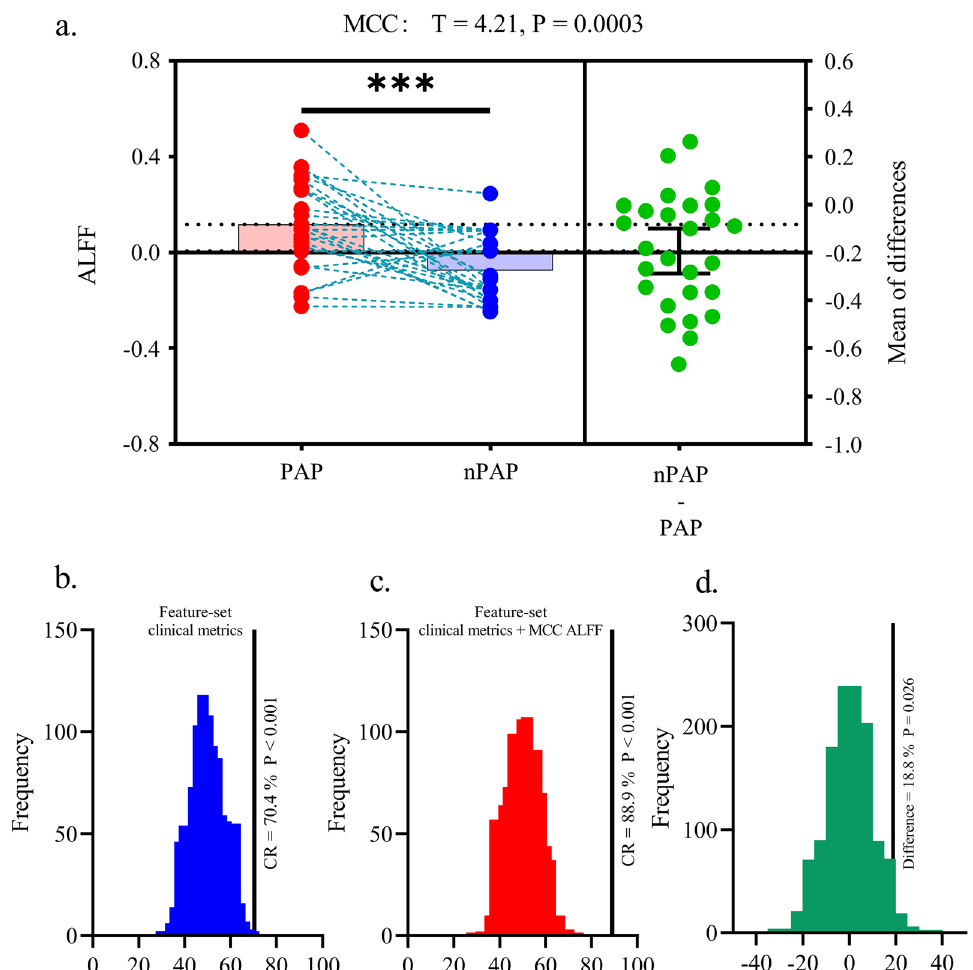
Fig. 4 a The paired t test for revealing the Amplitude of Low Frequency Fluctuation (ALFF) differences between postoperative axial pain (PAP)